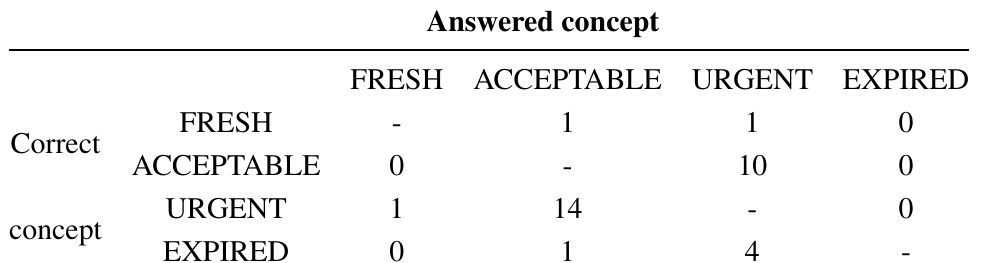
Table 4. Wrong answers in condition